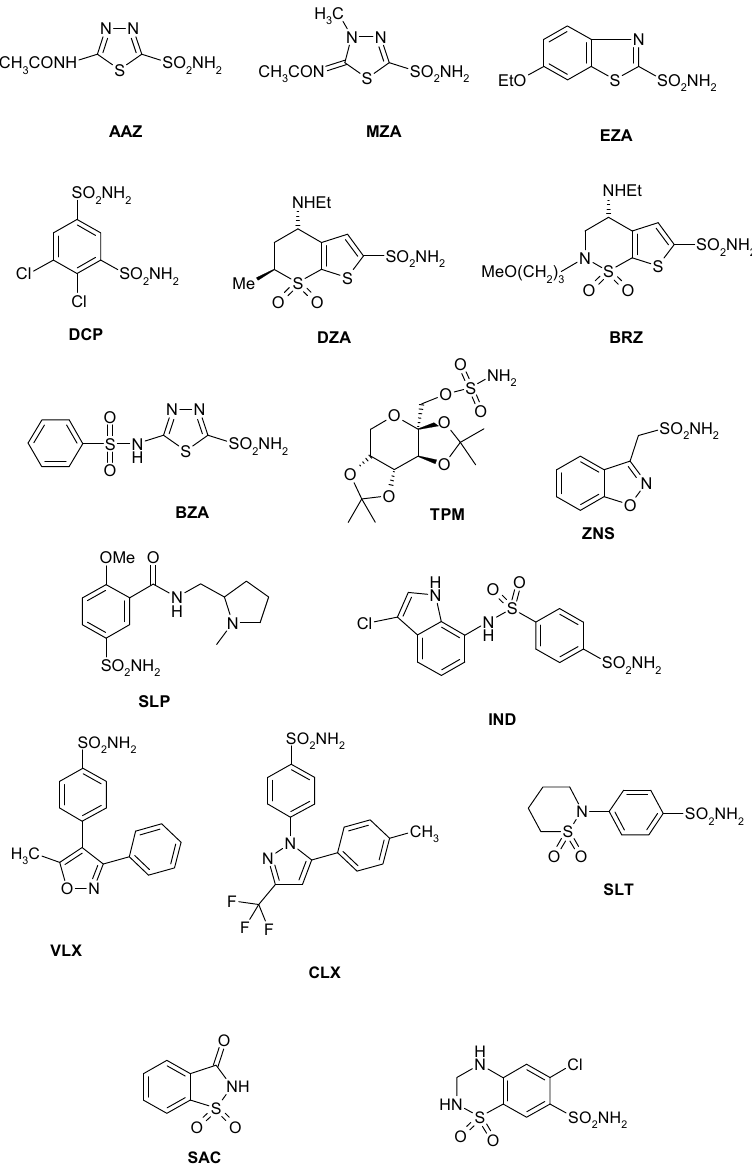
Figure 2. Sulfonamide ( 1–24 ) and sulfonamide/sulfamate derivatives (AAZ–HCT) investigated as Entamoeba histolytica (EhiCA) inhibitors in the present study.